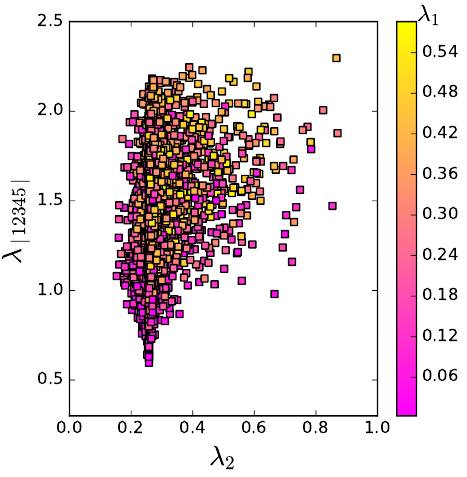
Figure 6 . For the type-II model, scatter plots of λ inflation and h 2 -inflation.